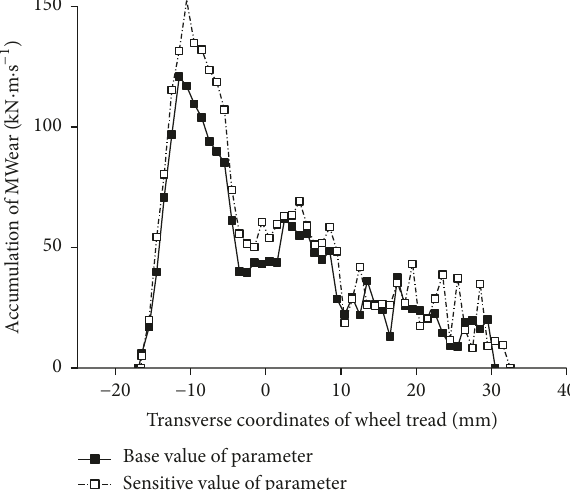
Figure 6: Influence of the vertical stiffness of tumbler journal box node on the cumulative wear power dissipation of the wheel.